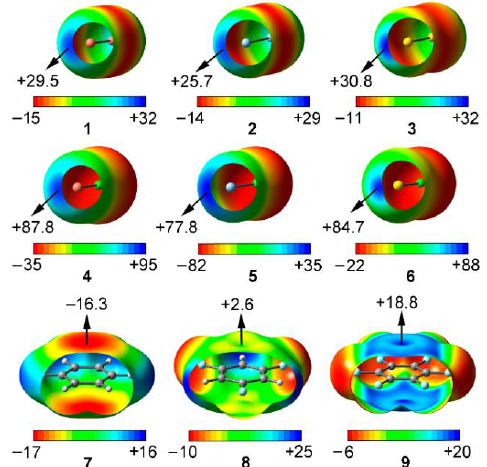
Figure 1. MEP surfaces of compounds 1 to 9 used in the study. Energies at selected points of the surface (0.001 a.u.) are given in kcal·mol − 1 .